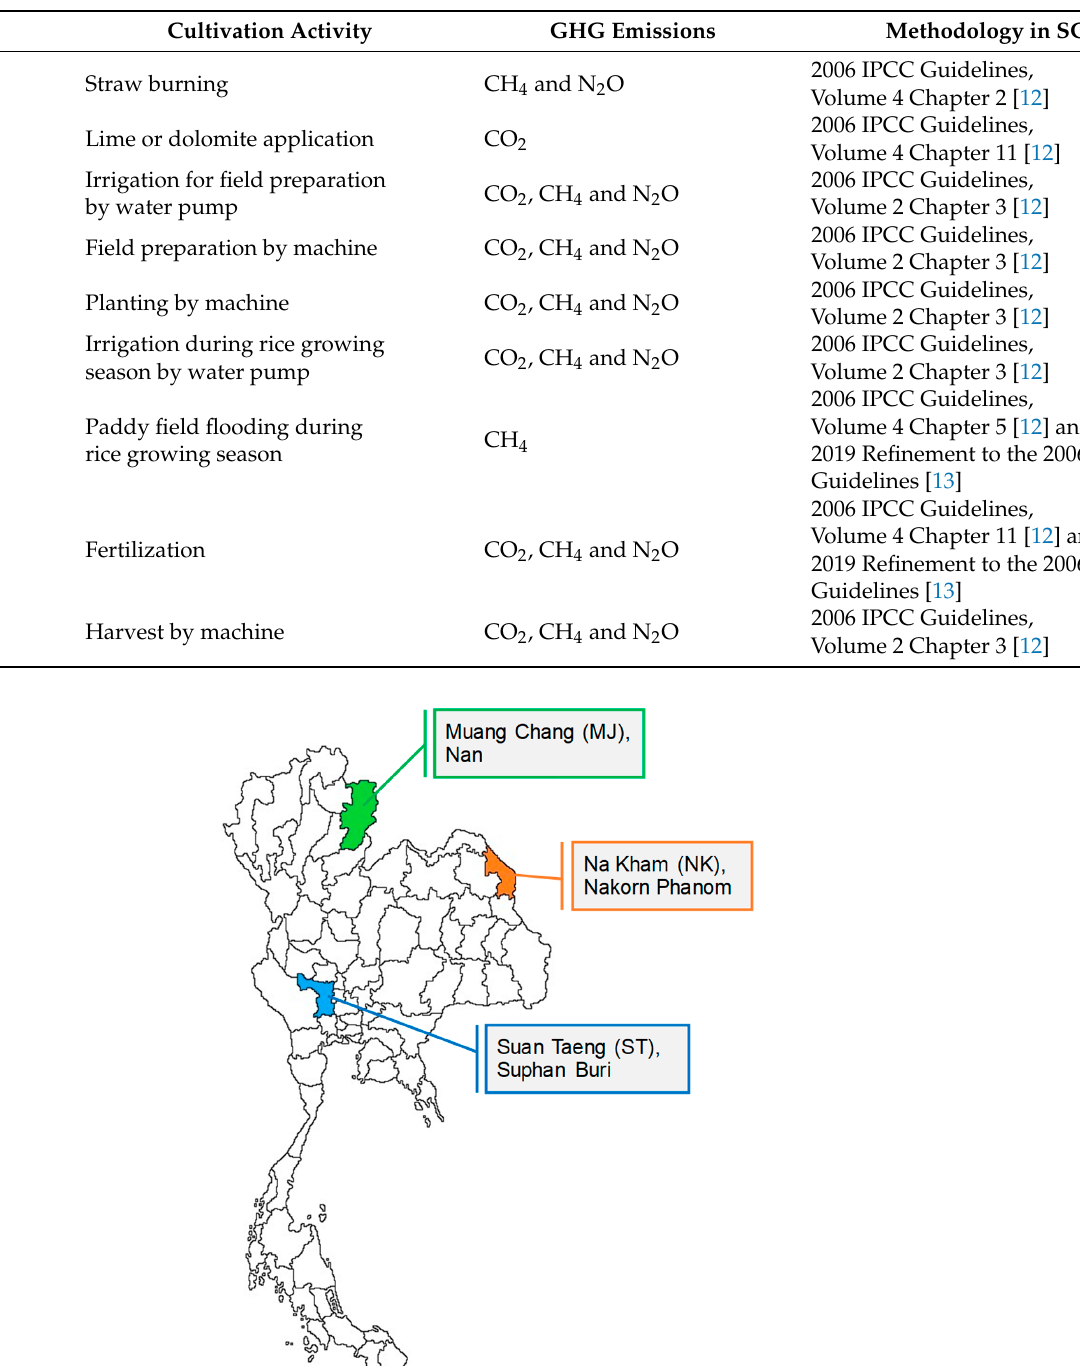
Table 1. Rice cultivation activities, GHG emissions and calculation method.